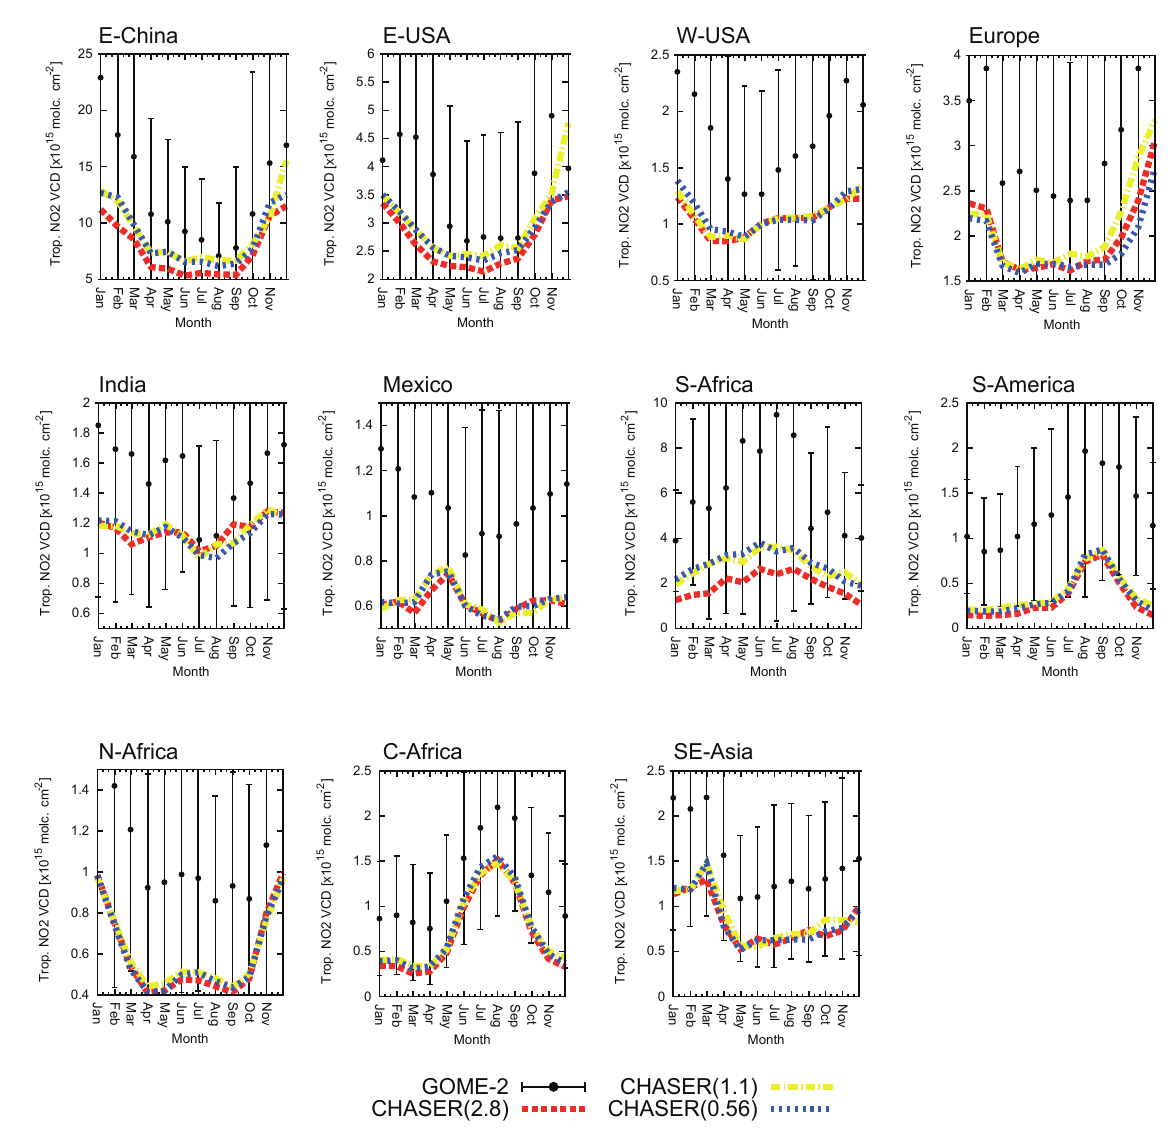
Figure 4. Same as Fig. 3, but for GOME-2.